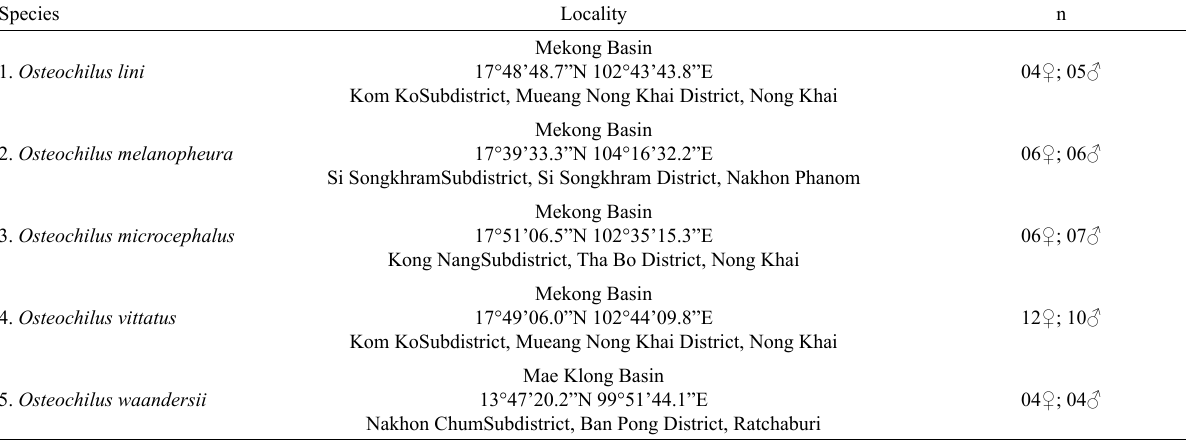
Table 2 – Species analyzed, collection sites and number of analyzed individuals (n). Species